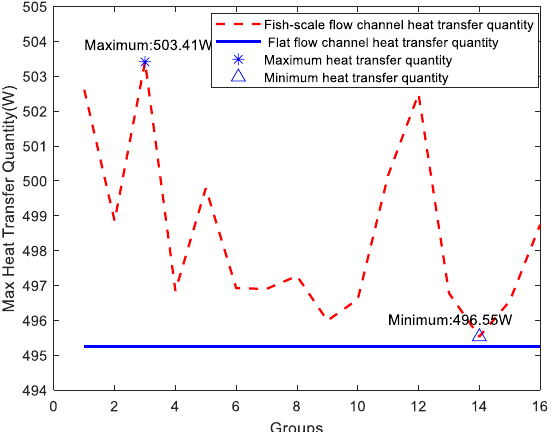
Figure 16 . Heat transfer quantity between cell and liquid cooling plate in group